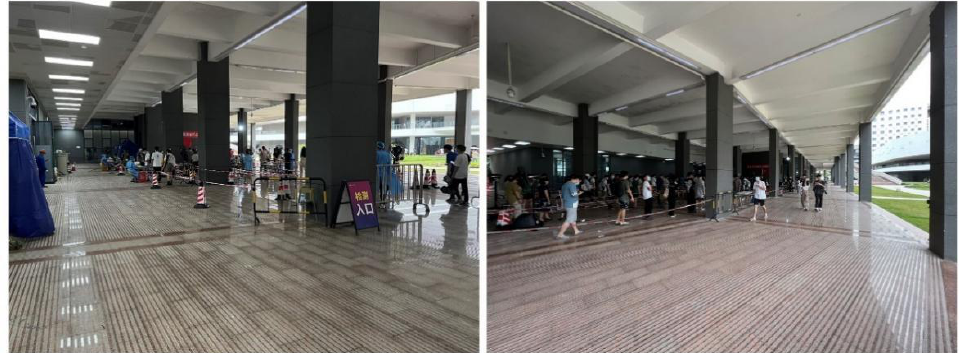
Figure 1. Nucleic acid test being conducted in an overhead space on the ground floor (Photos taken by the authors).